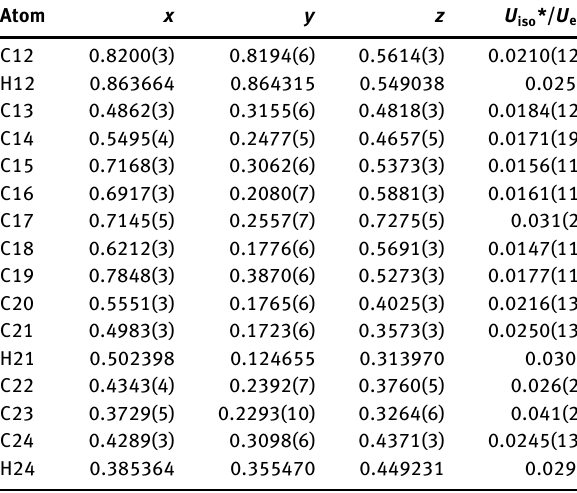
Table 2: Fractional atomic coordinates and isotropic or equivalent isotropic displacement parameters (Å 2